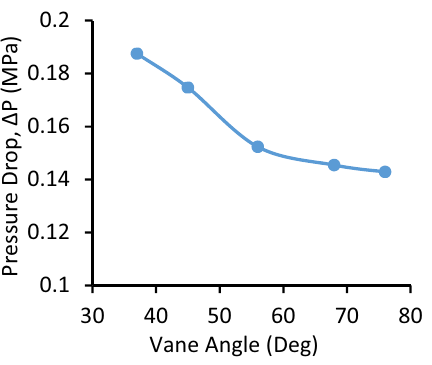
Fig. 9 Pressure drop vs vane angle for all the DOE generated cases